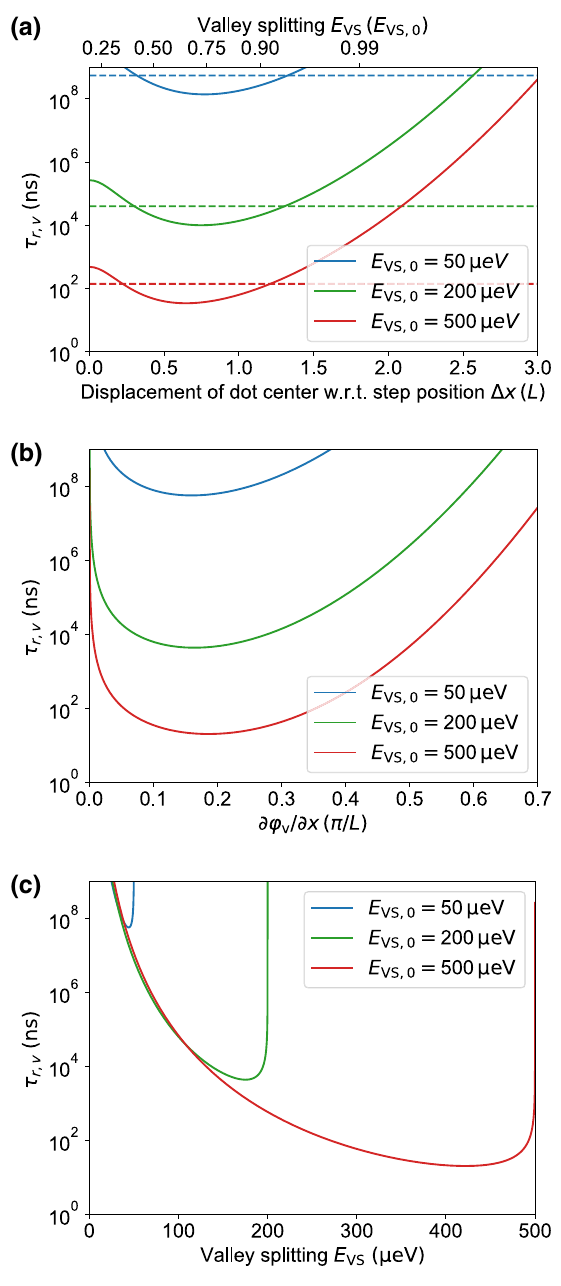
FIG. 13. Valley lifetimes for the step model (a) and linear val- ley phase model (b),(c). The dashed lines in (a) are the inverses of the relaxation rate averaged over the displayed region. A QD confinement energy of E orb = 1 meV is assumed for all cases.